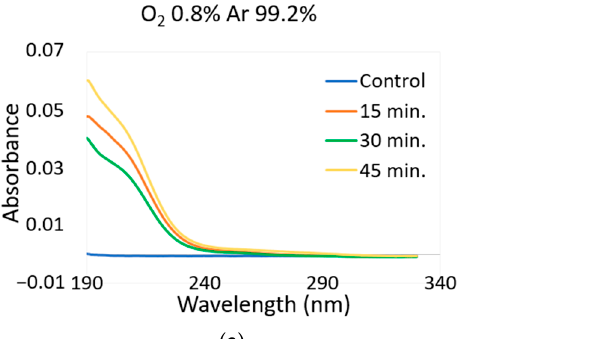
Figure 2. Discharge voltage and corresponding discharge current of ( a ) direct microplasma 900 V, air 2 L/min; ( b ) indirect treatment (plasma Jet) 2.4 kV, 1.2% O 2 3 L/min . Lissajours curve for ( c ) microplasma at 900 V, 27 kHz; ( d ) plasma jet at 2.4 kV, 30 kHz.